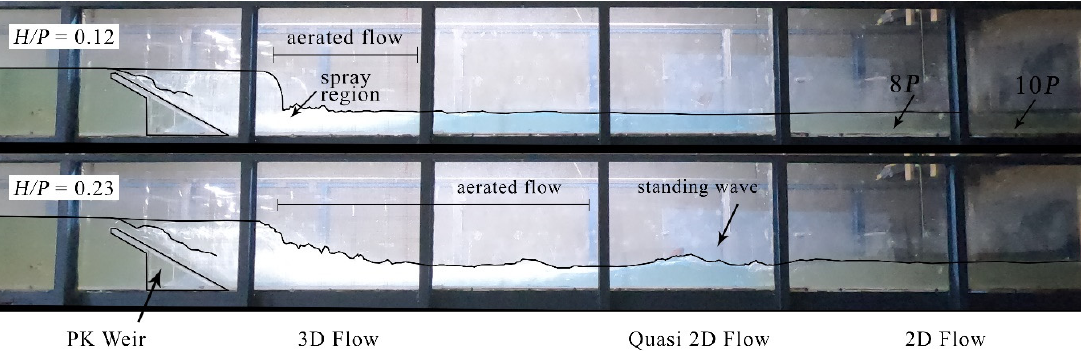
Figure 5. Type A PK weir flow field in section.